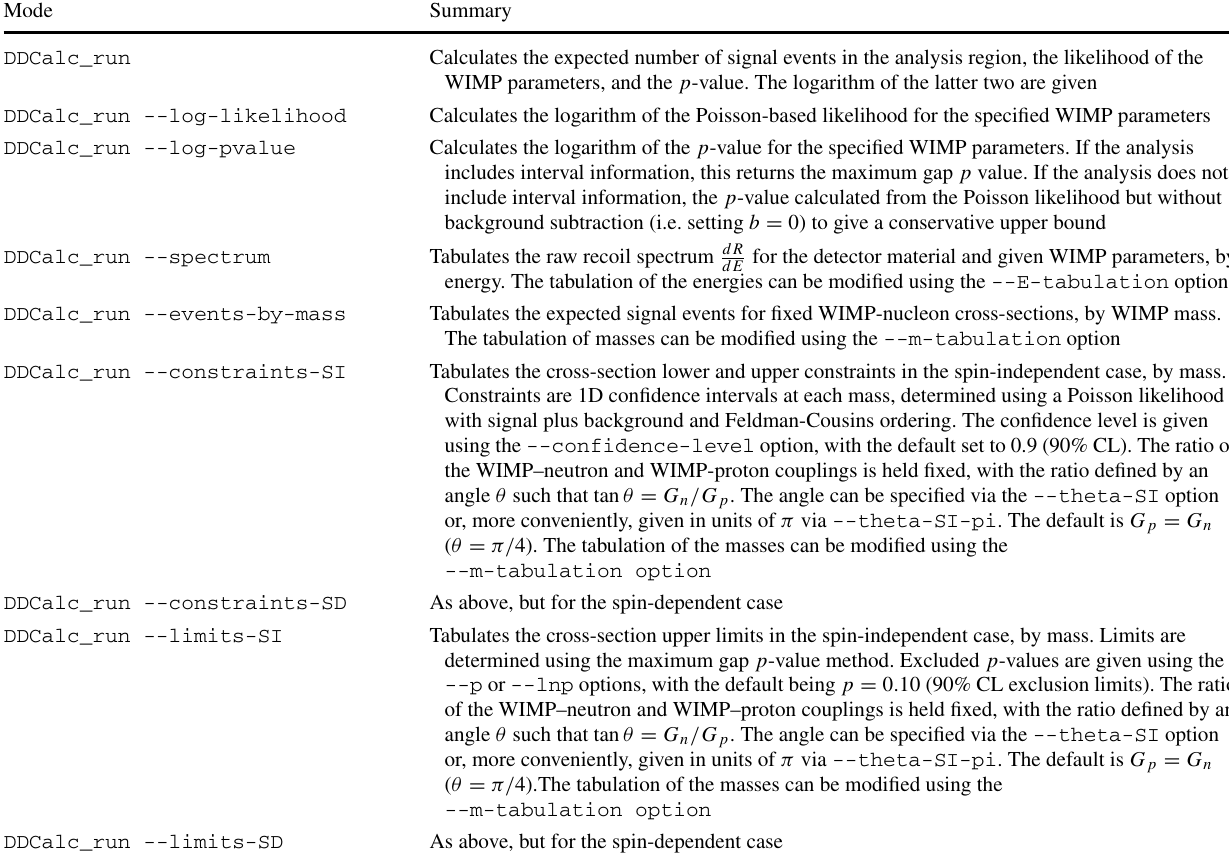
Table 3 The various run modes of the DDCalc default executable DDCalc_run Mode